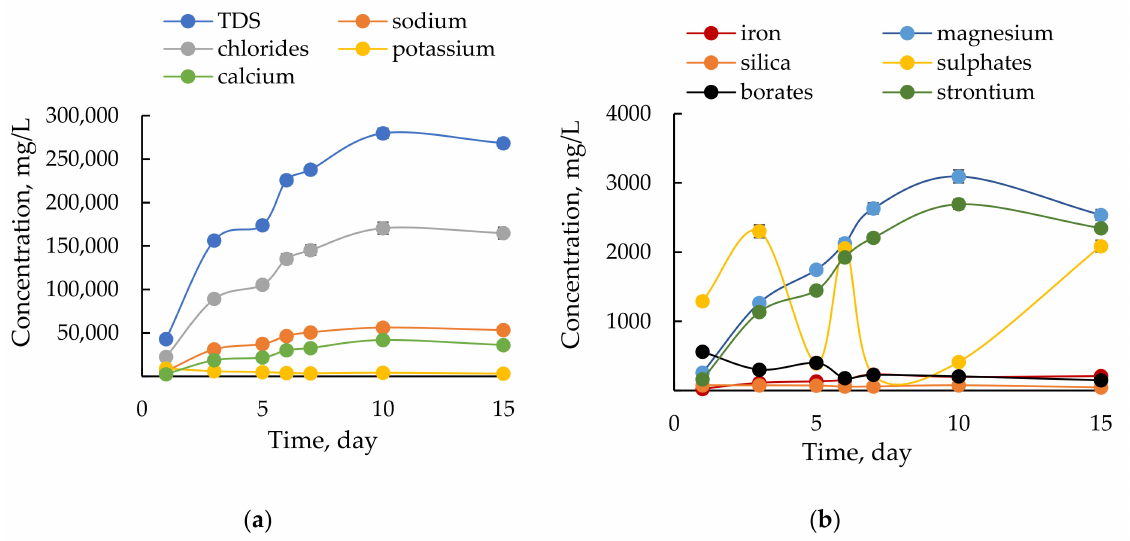
Figure 1. Temporal patterns of ( a ) major and ( b ) minor components in the